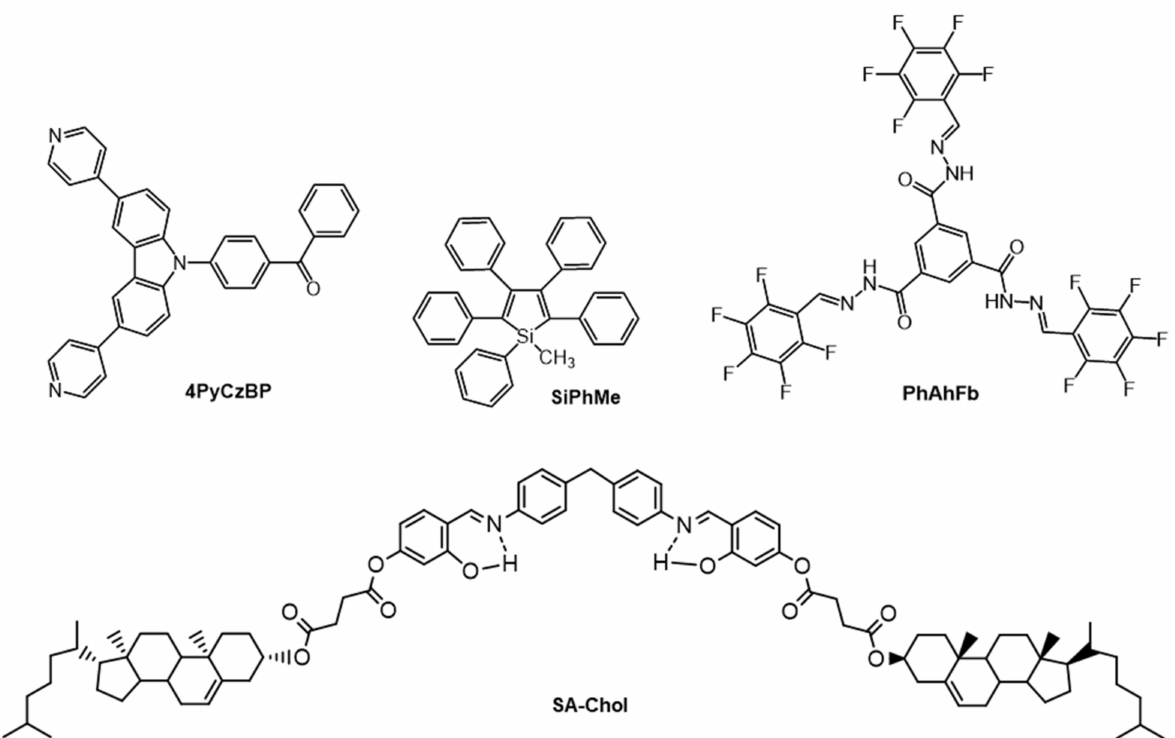
Figure 4. Molecular structures of 4PyCzBP, SiPhMe, PhAhFb and